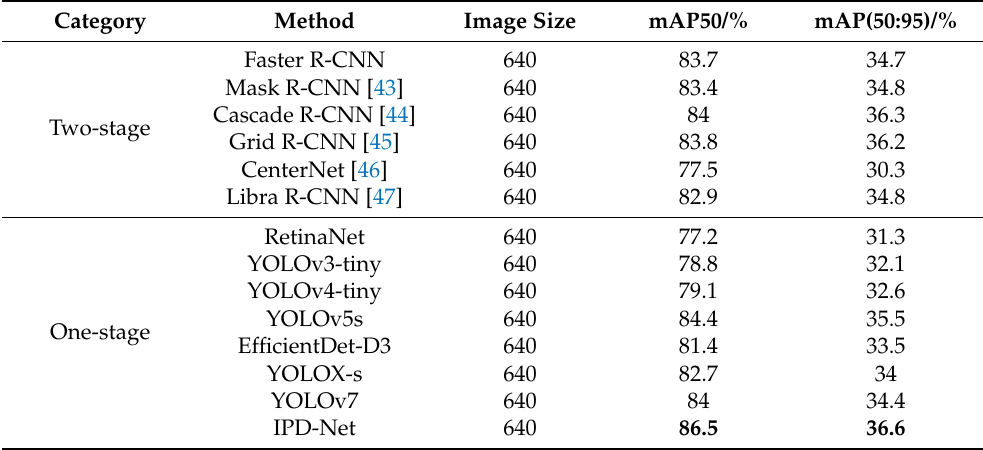
Table 4. Experimental comparison of IPD-Net with other models.